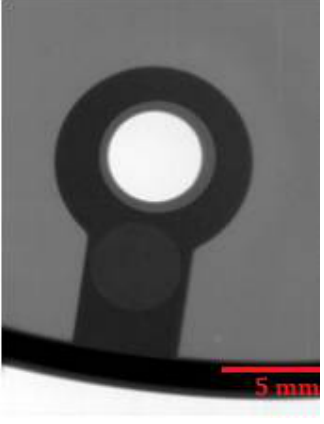
Figure 15. RTG—Sample 4.C.